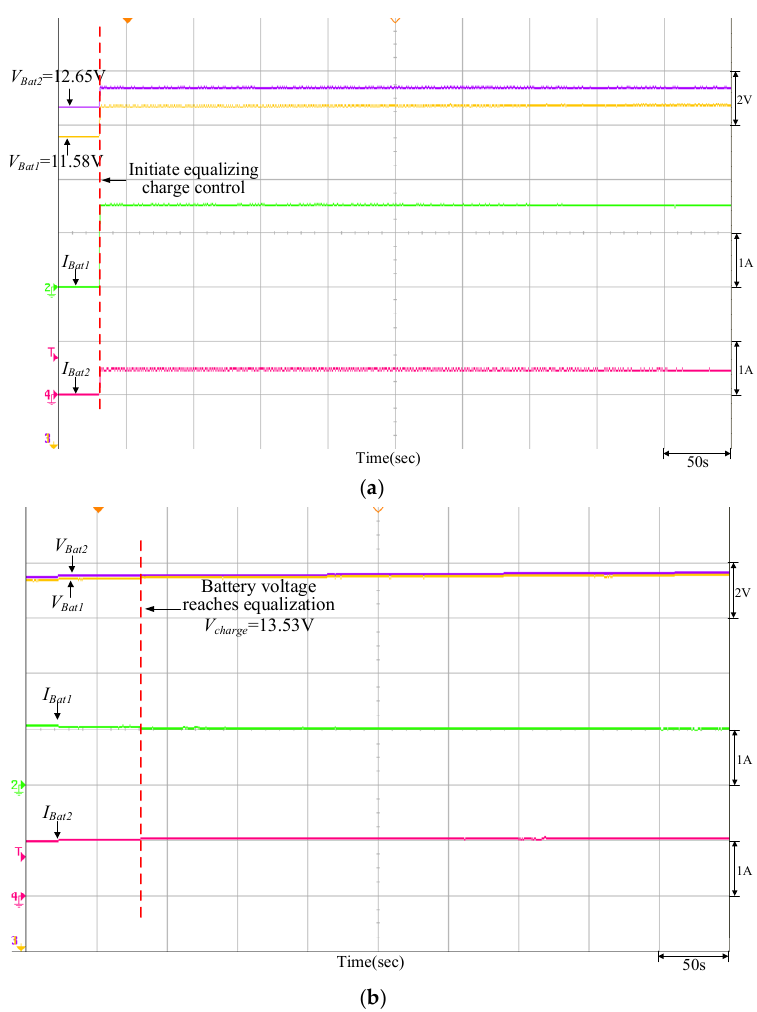
Figure 22. Equalizing charge control response of the quantitatively designed controller when V Bat1 = 11.58 V and V Bat2 = 12.65 V: ( a ) initiate equalizing charge control; ( b ) reach equalizing charge equalization.